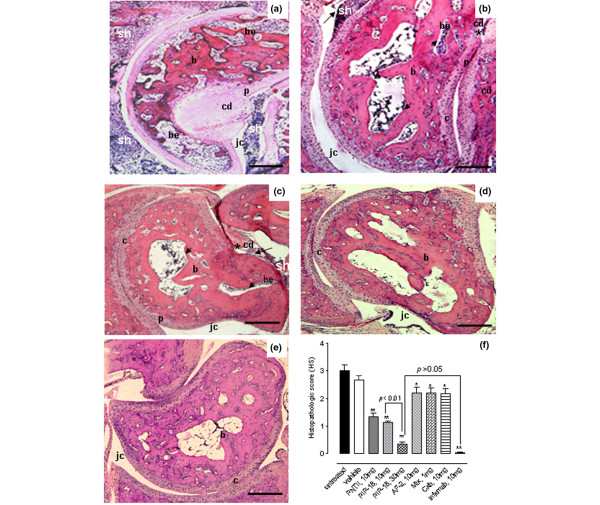
Histopathologic evidence of peptide-mediated disease modulation. H&E-stained representative ankle sections from Tg197 mice (a) without treatment, or after treatment with (b) 10 mg/kg and (c) 30 mg/kg of phospholipase inhibitor from python (PIP)-18, respectively for five weeks (n = 16 joints/group). The extent of synovial hyperplasia (sh), cartilage degradation (cd), and bone erosion (be) was less marked in the joints of (b, c) peptide-treated group than in (a) untreated joints, with histologic appearance more or less similar to that seen in the (d) infliximab treated or (e) normal (wild type) joints. Note the less marked hyperplasia (arrow), cartilage destruction (*) and bone erosion (arrowhead) in the representative joint of (c) 30 mg/kg PIP-18-treated group compared with that of (b) 10 mg/kg PIP-18-treated group. b = bone; be = bone erosion; c = cartilage; cd = cartilage degradation; jc = joint cavity; sh = synovial hyperplasia. (f) Mean histopathologic scores (HS) are shown for different treatment groups. Compared with untreated mice, P-NT.II, PIP-18 and infliximab treatment significantly decreased HS (**P < 0.001) as did treatment with antiflammin-2, methotrexate (Mtx), and celecoxib (Cxb), which were less effective (*P < 0.01). Higher dose (30 mg/kg) of PIP-18 was more effective than the lower dose (10 mg/kg) (*P < 0.01). One-way analysis of variance with Bonferroni's multiple comparison post test. Bars = 500 μm. Infliximab (10 mg/kg) and 30 mg/kg PIP-18 had similar modulatory effect on HS (P > 0.05, two-tailed paired t-test).